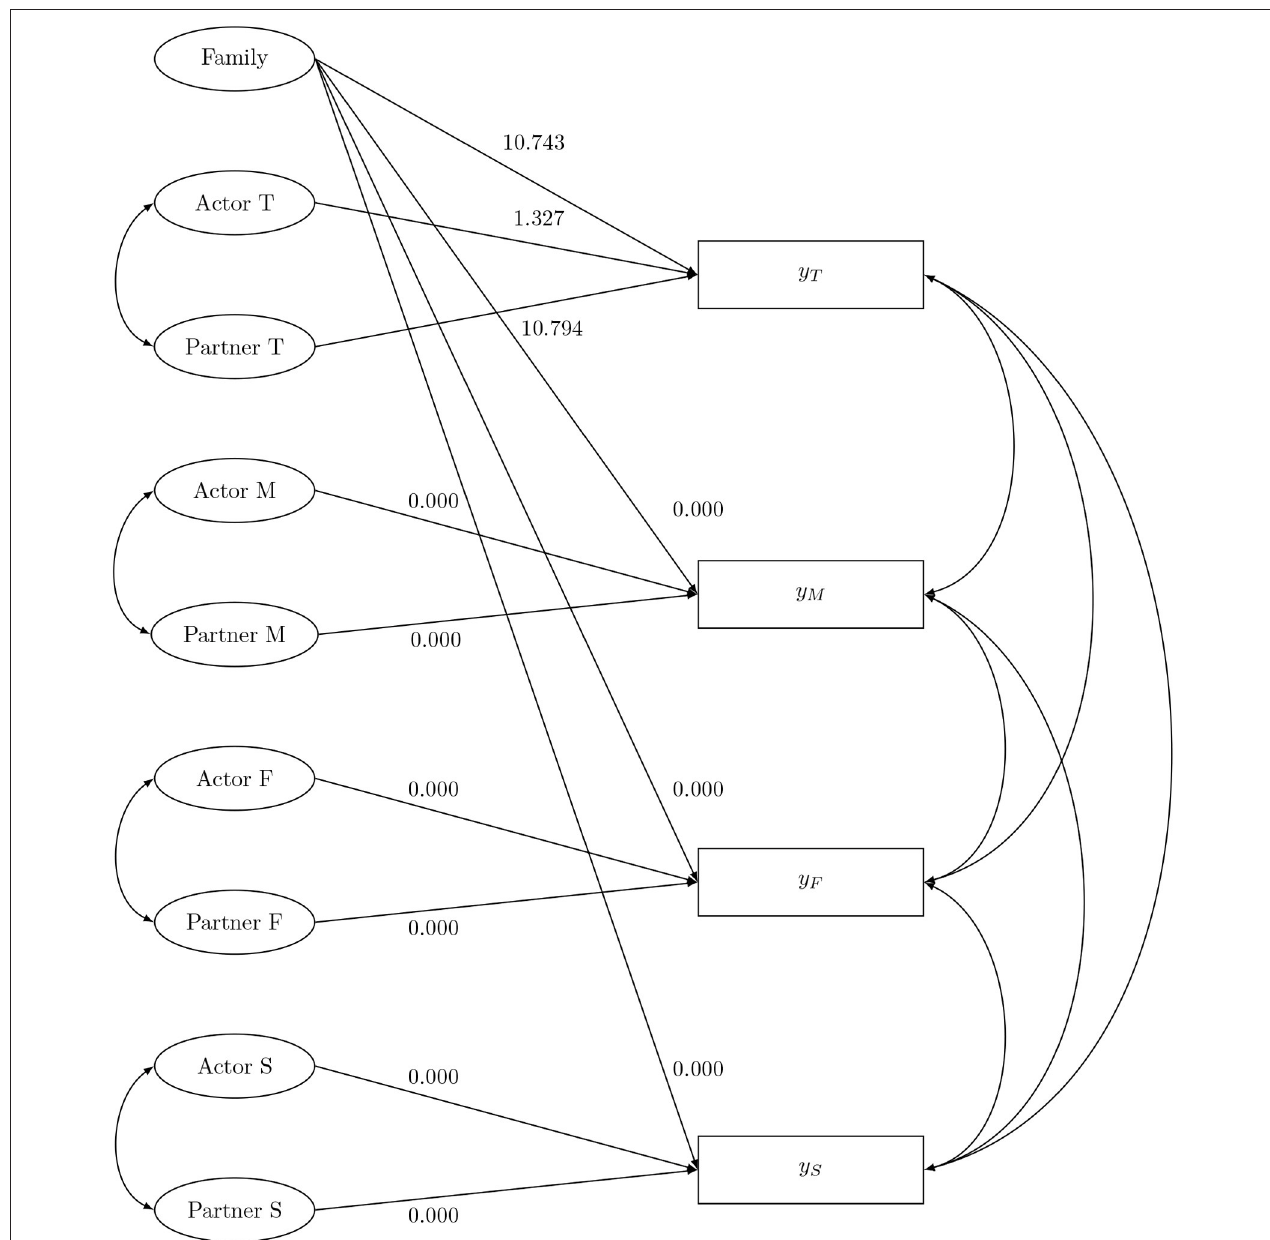
FIGURE 4 | The social relations model components as predictor: data-generating